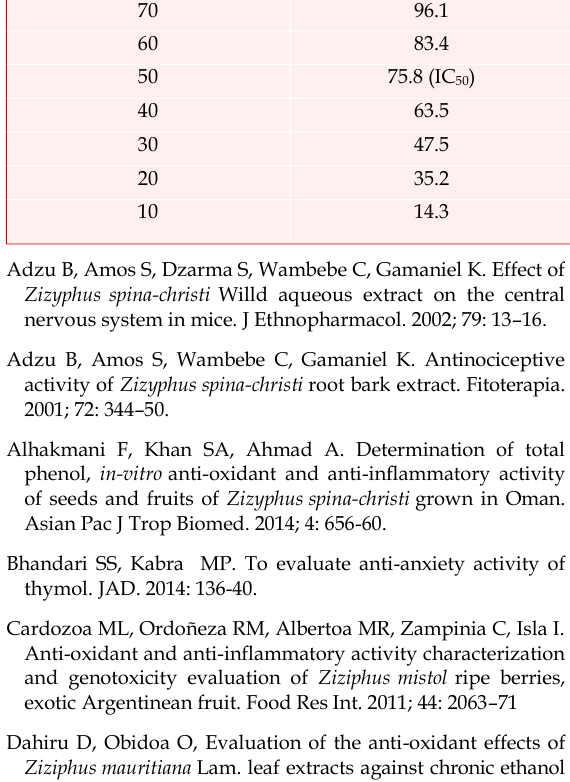
Anti-oxidant capacity of Zizyphus spina-christi extract DPPH radical scavenging activity inhibition (%) IC